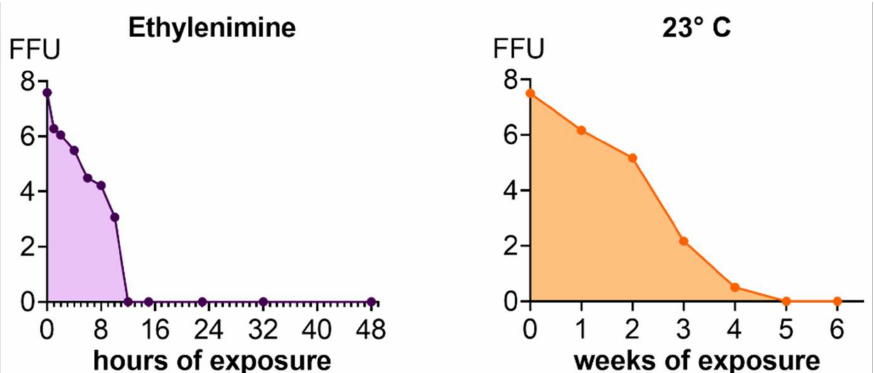
Figure 3. Inactivation kinetics of BoDV-1 “Dessau” during binary ethylenimine treatment ( left ) and storage at room temperature ( right